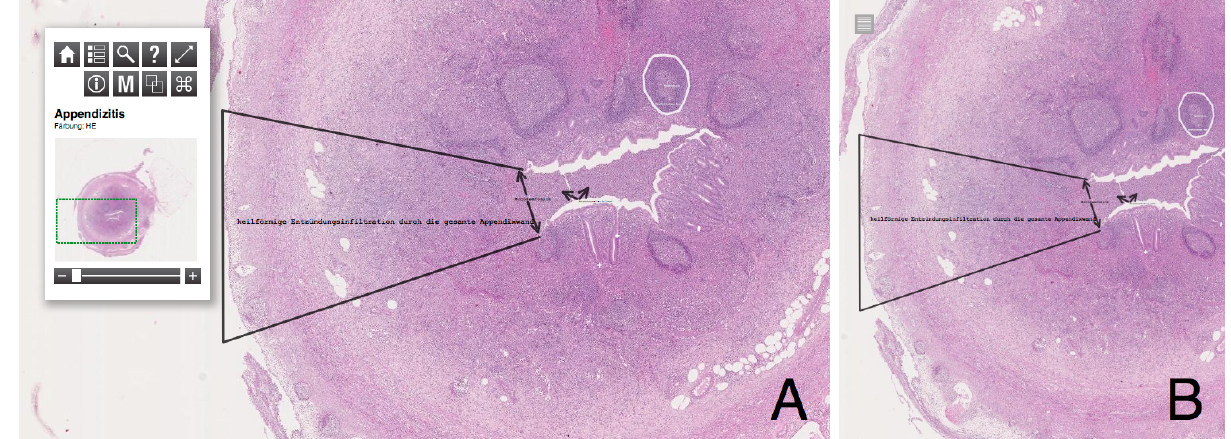
Figure 5. Side-by-side view of desktop layout (A) versus mobile layout (B) depicting appendicitis (ie, inflammation of the appendix). The control panel folds if the screen resolution is too small (B) to provide an unhindered view on the slide. Pathological annotations are